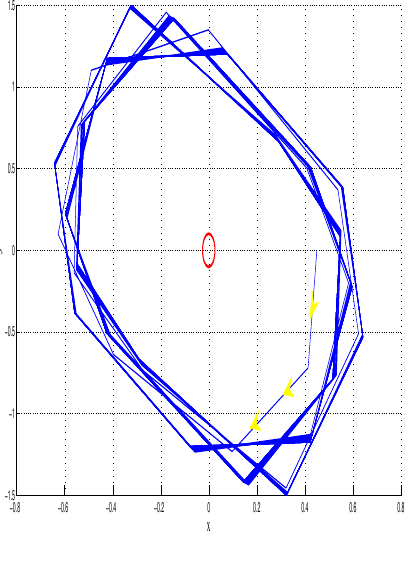
Figure 12. The numerical solutions generated by the NSFD scheme with h = 1 . 0 and t ∈ [0 , 1000] in Example